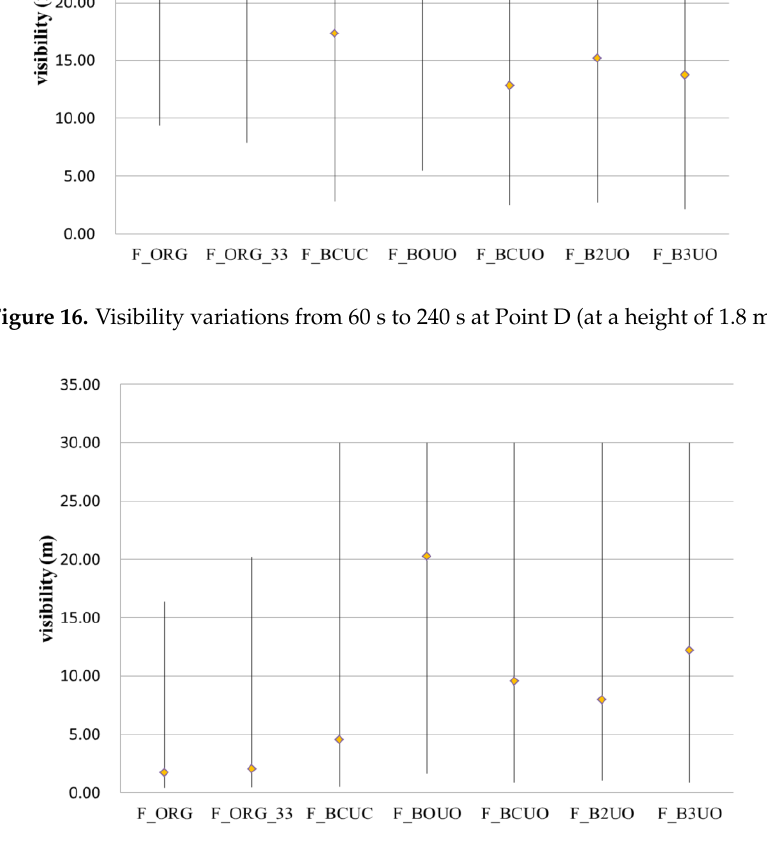
Figure 17. Visibility variations between 60 s and 240 s at Point R (at a height of 1.8 m).